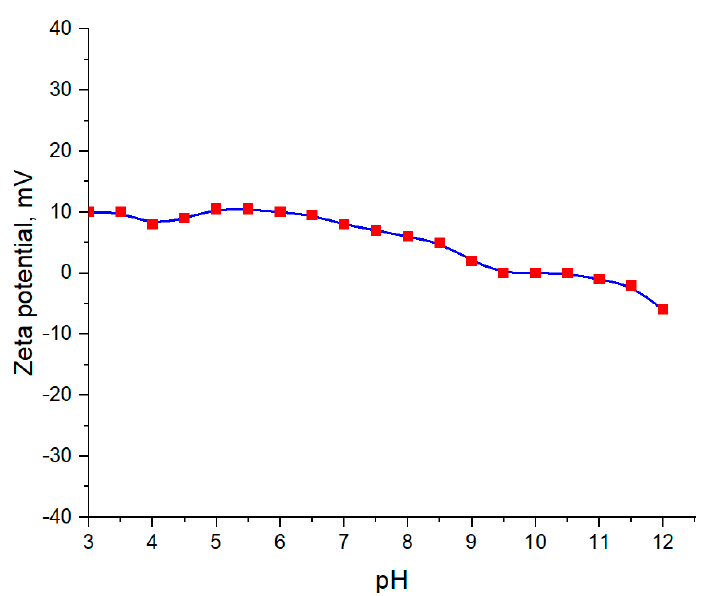
Figure 11. Measurements of pH and zeta potential of aqueous suspension of BaTiO 3 (without SAP).